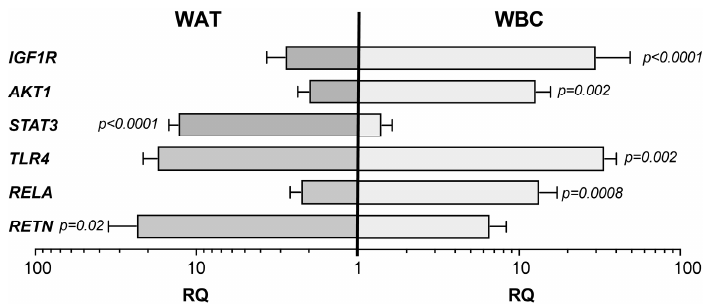
Figure 1. Gene expression analysis in leukocytes and in subcutaneous adipose tissue of patients with rheumatoid arthritis. Gene expression analysis was done in leukocytes of the peripheral blood (WBC, n = 95) and in subcutaneous adipose tissue (WAT, n = 83) of female RA patients by real-time PCR. Relative quantity (RQ) of expression for each gene was calculated in relation to the reference group that consisted of 11 young (mean age 38.4 years) non-smoking methotrexate-treated female RA patients with normal body weight and their disease in remission. Statistical comparison between gene expression in WBC and WAT samples was done with the nonparametric Mann-Whitney U test. The bars present mean with SEM. IGF-1R , insulin-like growth factor 1 receptor; AKT1 ,